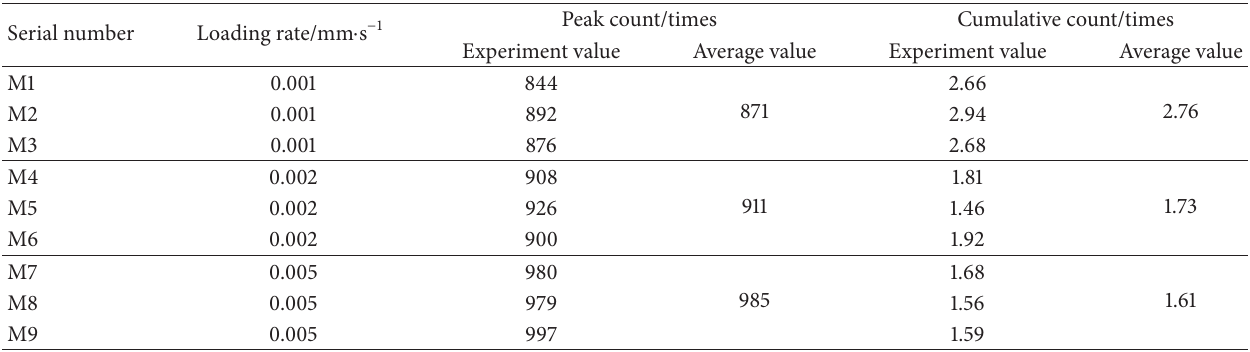
Table 2: Acoustic emission parameters of coal